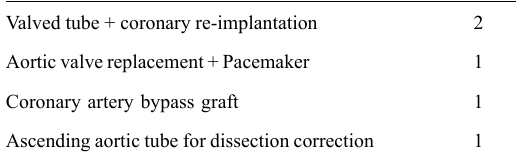
Table 3. Right Carotid Perfusion - Previous Operations Valved tube + coronary